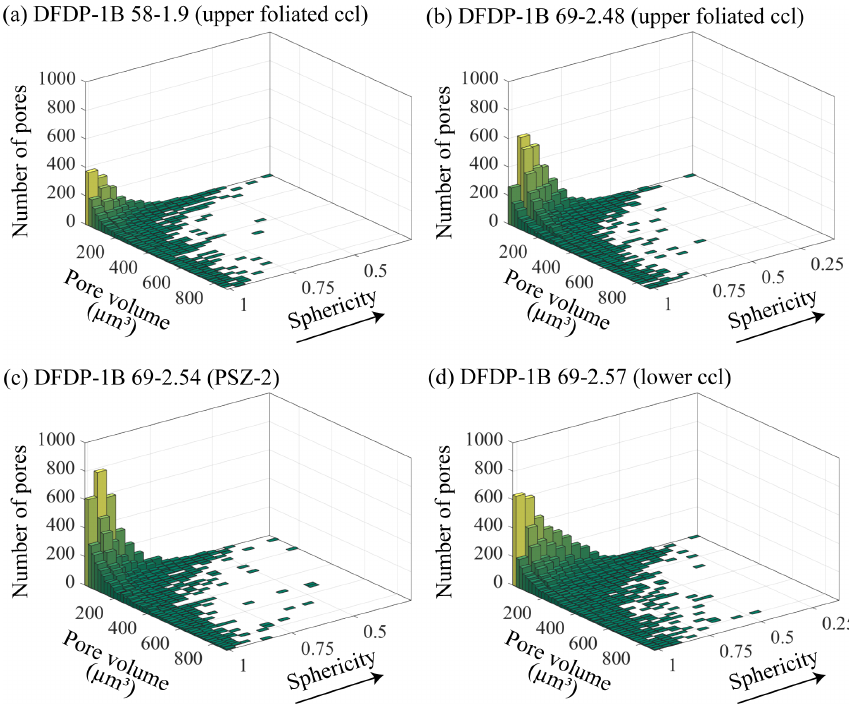
Figure 5. Bivariate histograms showing sphericity vs. pore volume (µm 3 ) and number of pores for each sample. The arrow indicates the direction of increasing sphericity. Here, the sphericity is defined as the ratio between the smallest and the largest eigenvalues (i.e., axis) of each